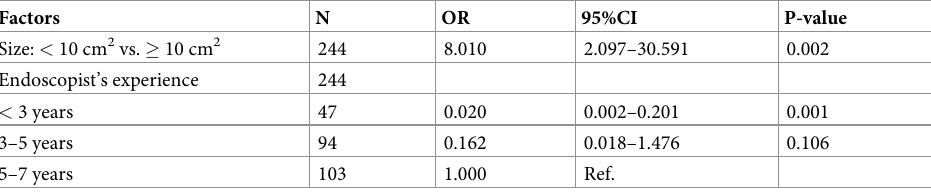
Table 5. Multivariate logistic regression analysis for the long ESD time (procedure time � 100